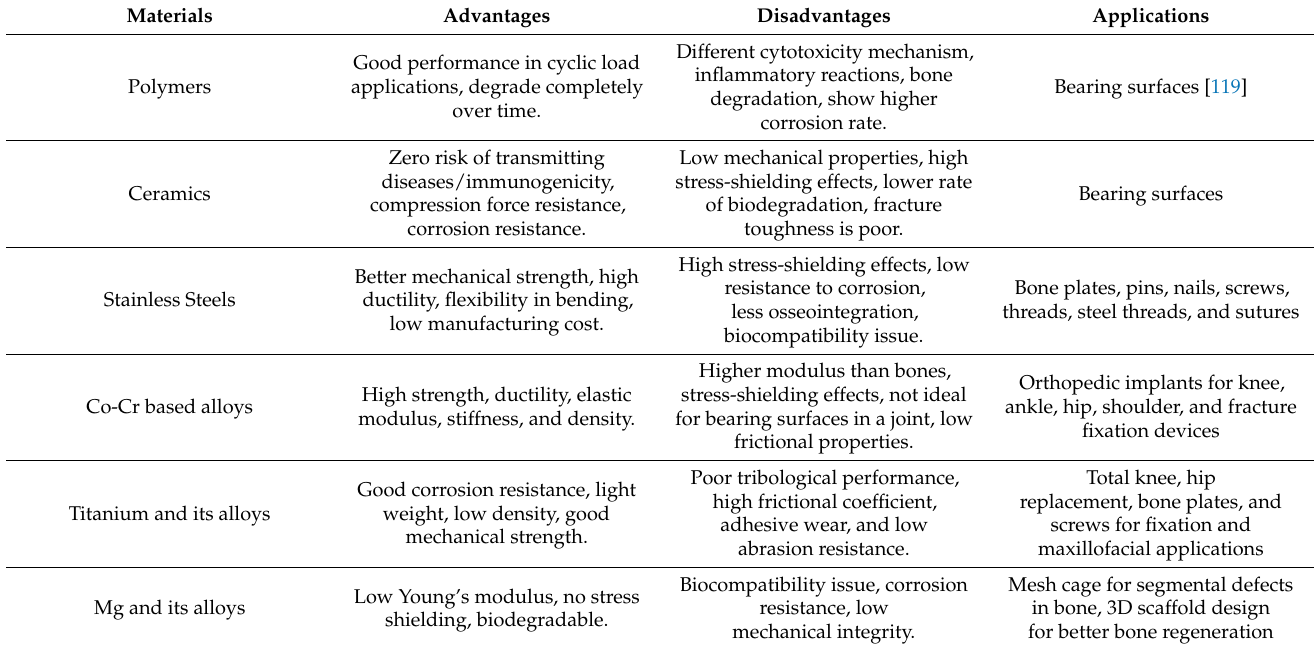
Table 2. The pros and cons of various biomaterials used in the biomedical industry